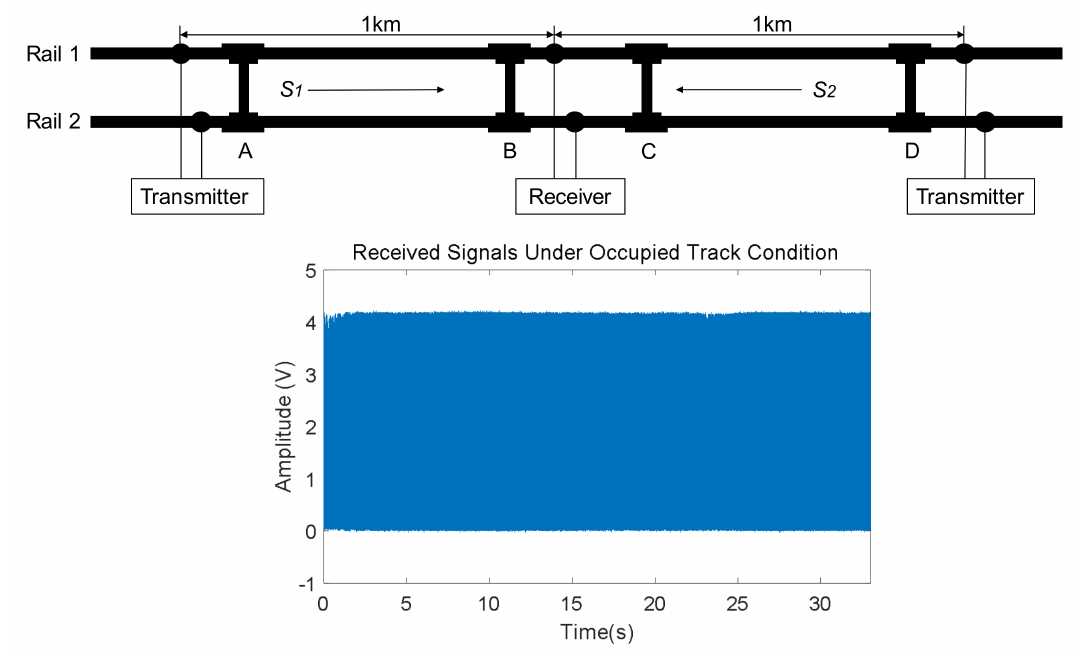
Figure 8. Example of received UGW signals in rail no. 2 for an occupied track